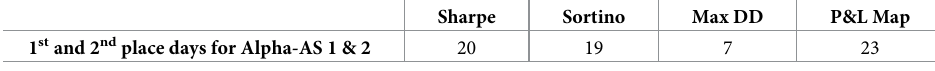
Table 6. Number of days either Alpha-AS-1 or Alpha-AS-2 scored best out of all tested models, for each of the four performance indicators. Sharpe